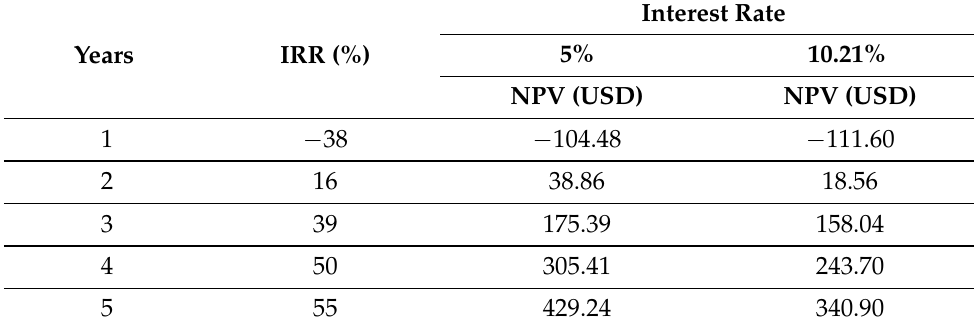
Table 3. Sensitivity analysis of first proposal.